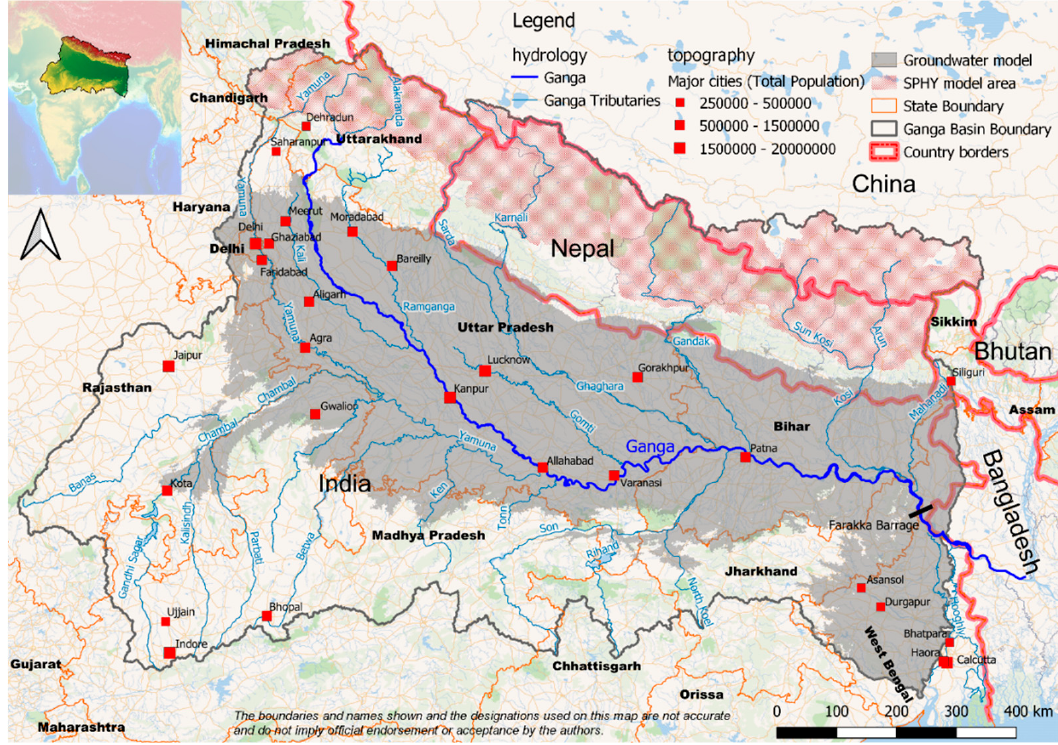
Figure 1. Ganga river basin map. Background based on Wikimedia unlabeled layer.